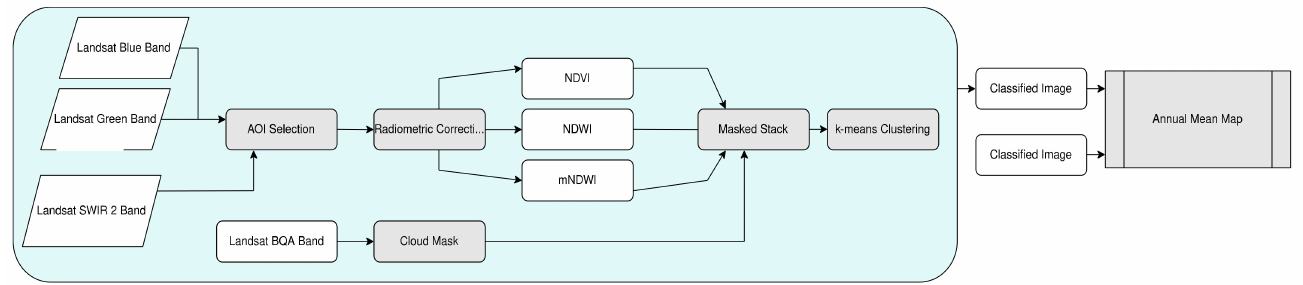
Figure 5. Yearly average map composition